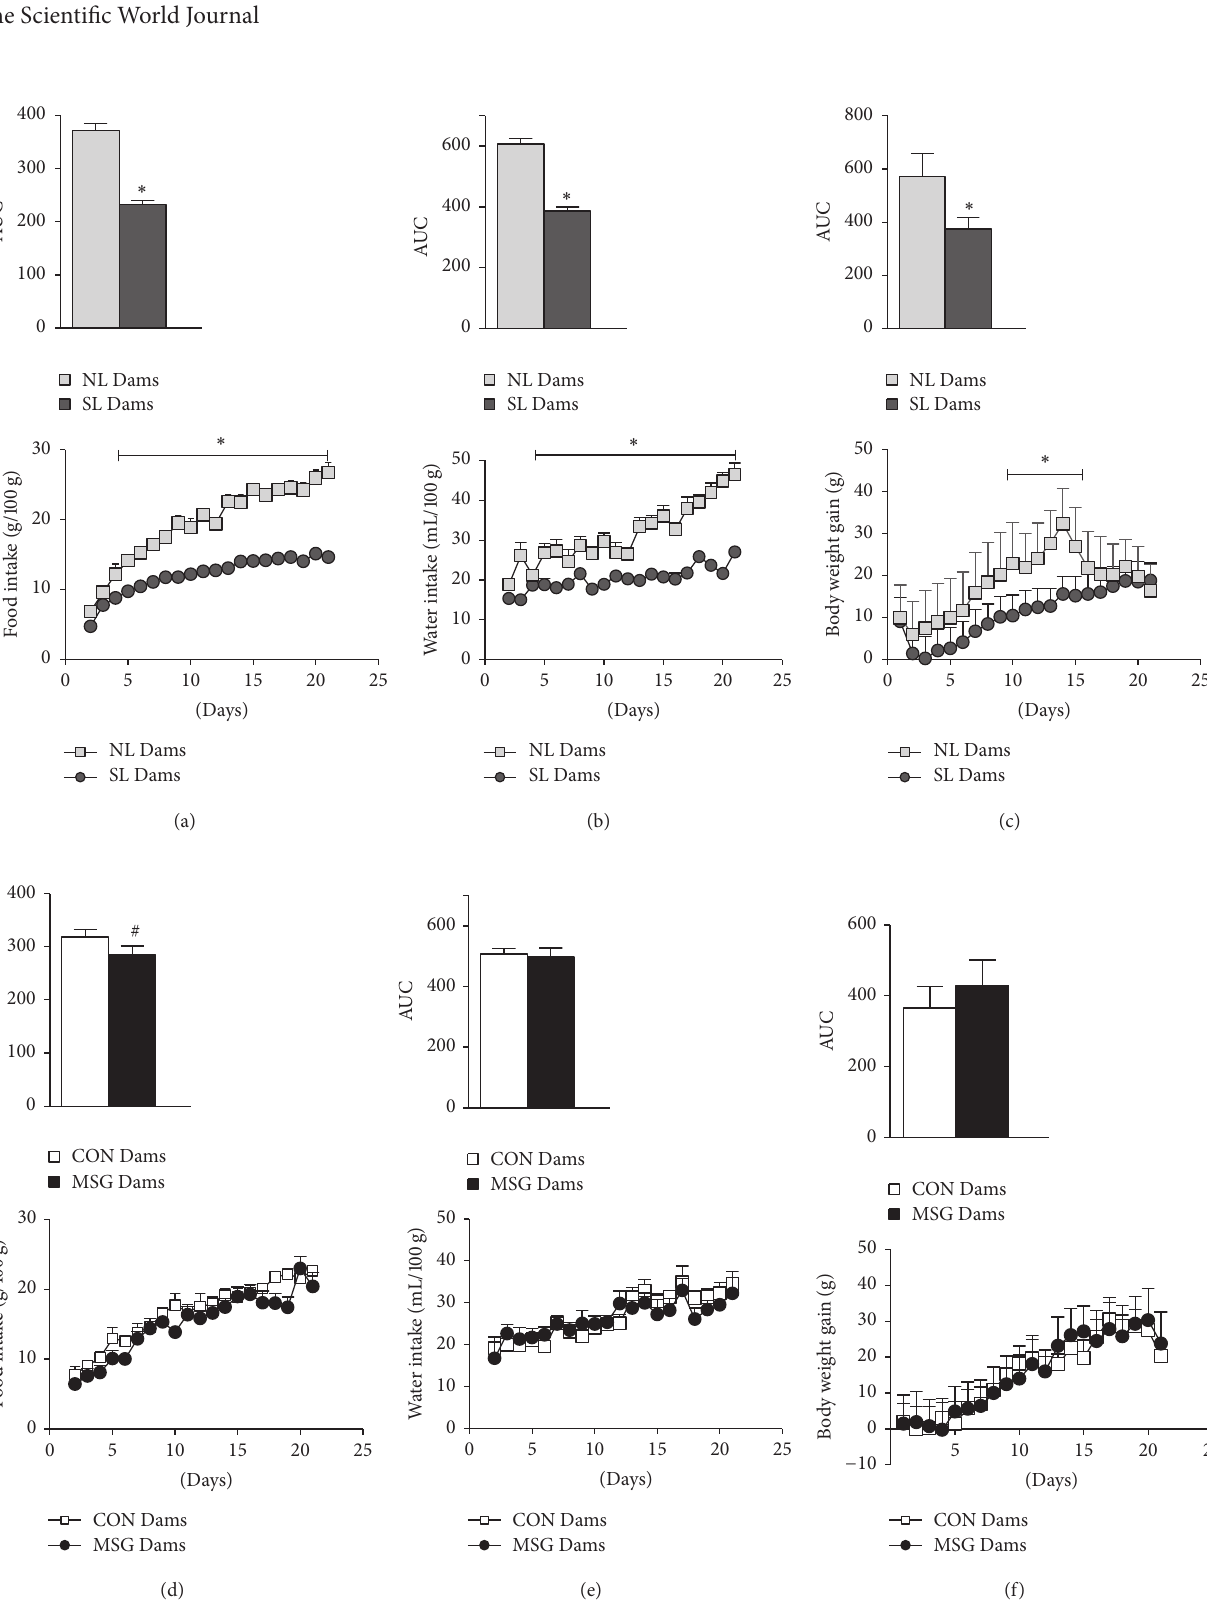
Figure 1: Food intake, water intake, and body weight gain in lactating dams. Food intake (a, d), water intake (b, e), and body weight (c, f) of lactating dams from the 1st to 21st day of lactation. Data are the means ± SEM ( 𝑛 = 8 –10 dams/group). Symbols above the bars represent statistical differences according to Student’s t -test ( 𝑝 < 0.05 ). ∗ NL Dams versus SL Dams; # CON Dams versus MSG